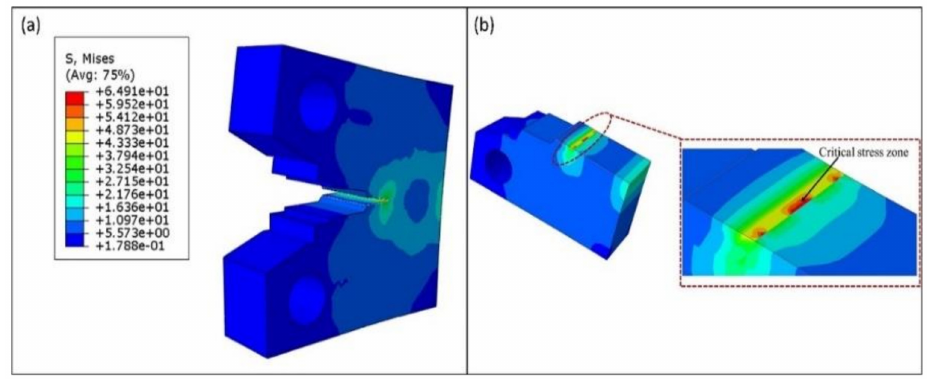
Figure 24. ( a ) Stress contour plot in CT specimen at crack vicinity and ( b ) Sectional view for a better insight on critical stress along with the thickness. Reprinted with permission from ref. [84]. 2020, John Wiley.